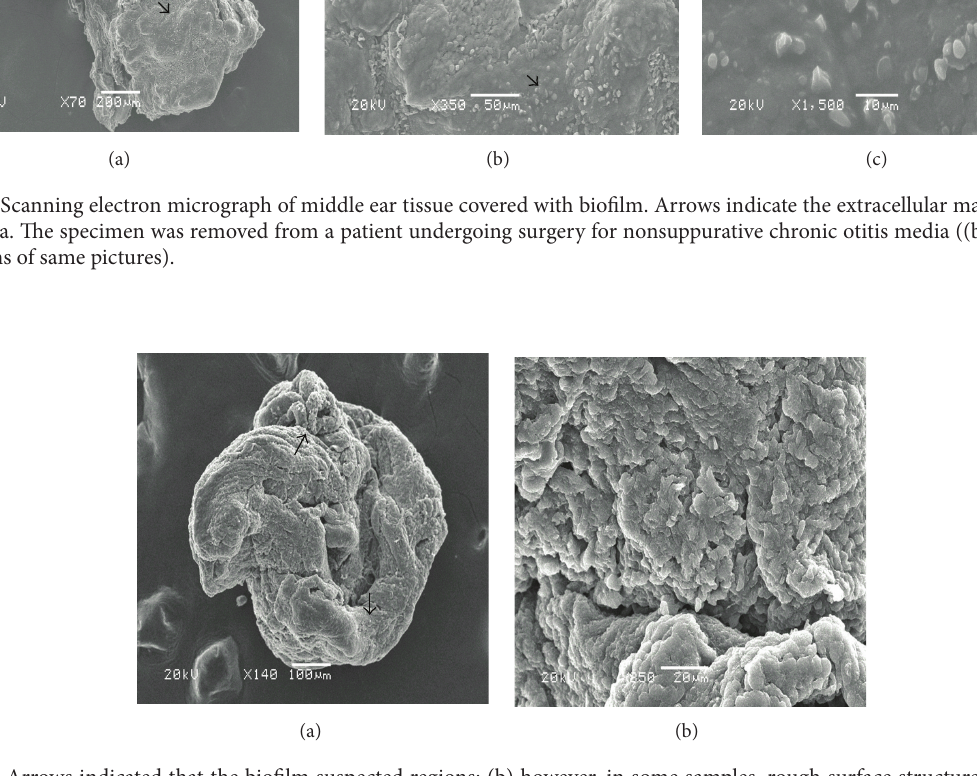
Figure 2: (a) Arrows indicated that the biofilm suspected regions; (b) however, in some samples, rough surface structure was seen as the magnification increased.